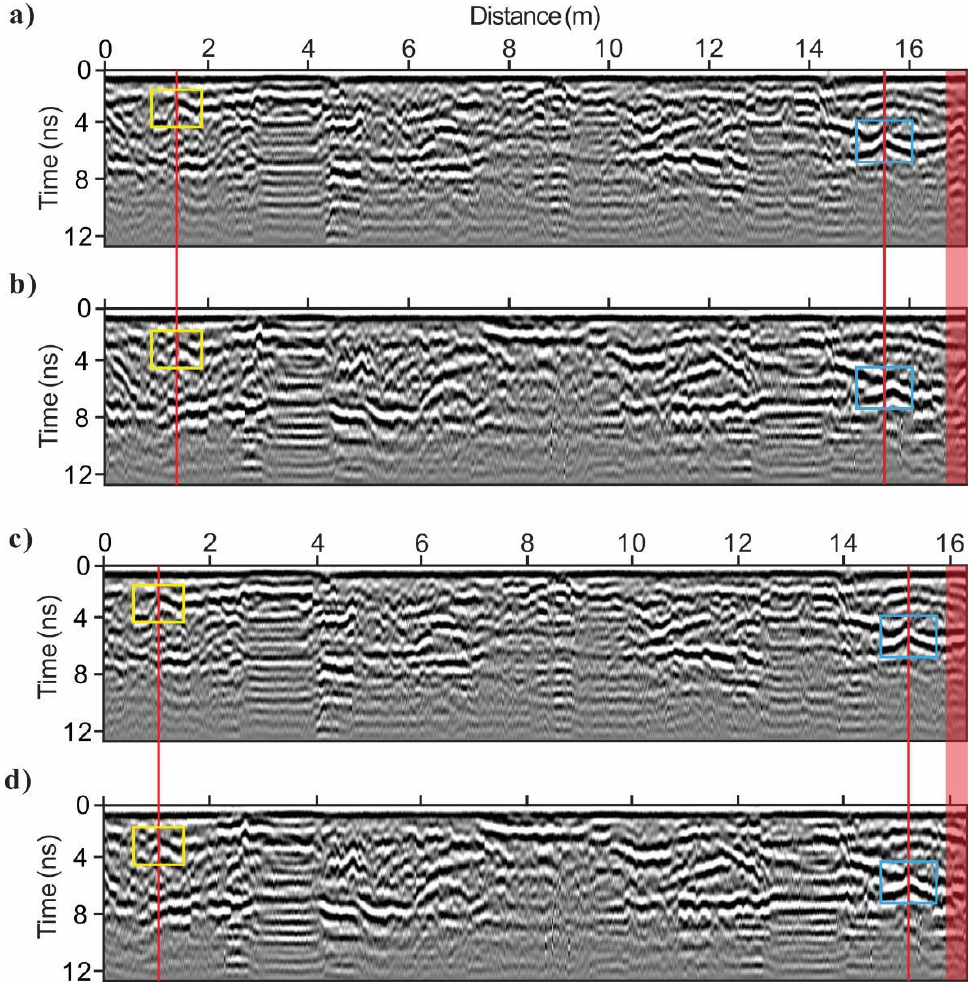
Figure 6. Spatial position matching of the time-lapse GPR data: ( a , b ) before matching; ( c , d ) after matching.